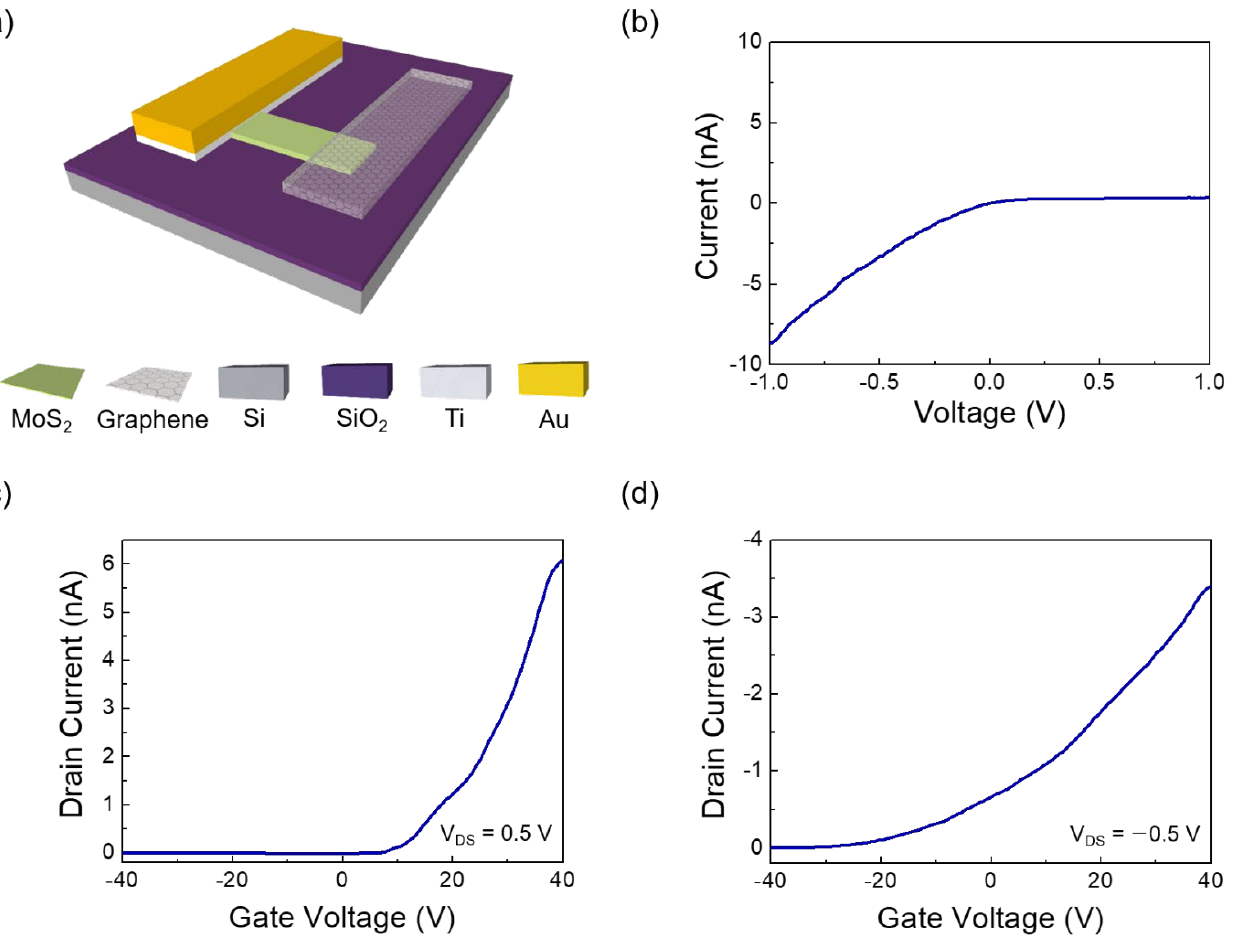
Figure 3. Schematic and electrical properties of MoS 2 field-effect transistor (FET) with heteroelectrodes. ( a ) Schematic of MoS 2 FET with heteroelectrodes; ( b ) I DS –V DS output characteristics; ( c ) I DS –V g transfer characteristics at V DS = 0.5 V; ( d ) I DS –V g transfer characteristics at V DS = − 0.5